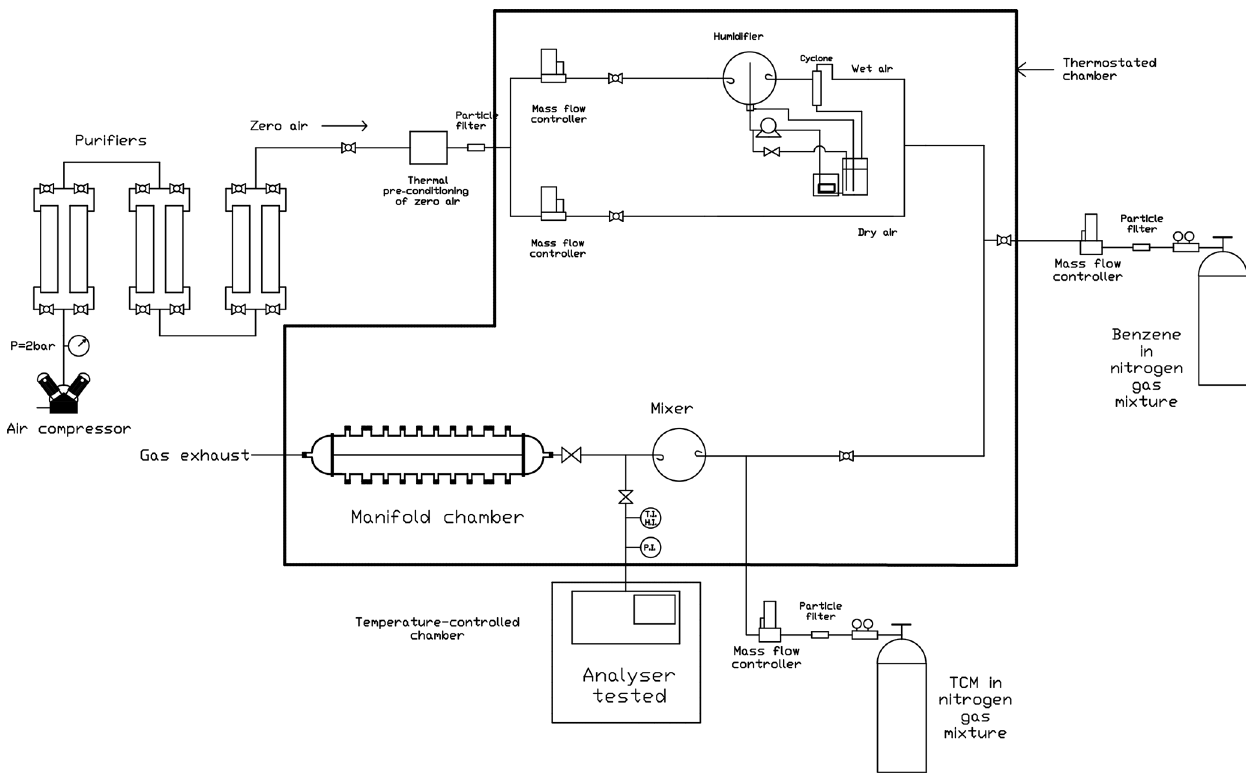
Figure 1. Schematic of the components of the controlled atmosphere chamber used to obtain gas mixtures of benzene in the air with and without potential interferent substances. (HI: humidity indicator; TI: temperature indicator; PI: pressure